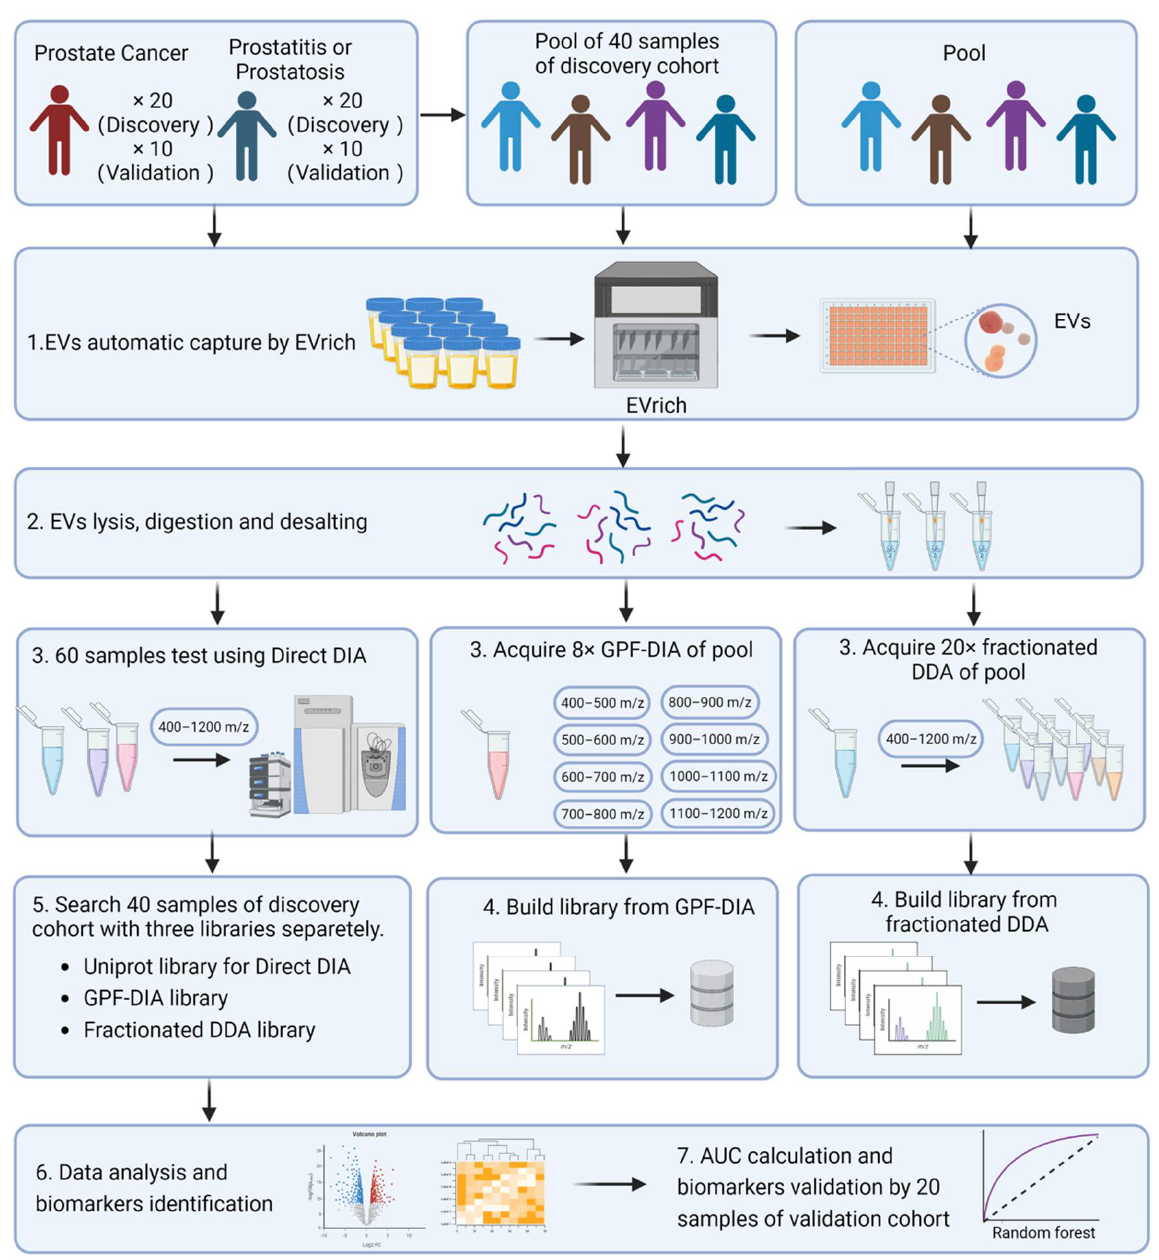
Figure 1. Experimental Design and Workflow of the Study. (Created by BioRender.com) EVs were separated in urine samples collected from all participants. We then used the EVTRAP method to capture and isolate the EVs. For the establishment of the library for MS searching, in this step, the samples from all 40 participants of the discovery cohort were pooled as the main library for GPF-DIA-base search, while other independent 40 biological samples were pooled and conducted as a secondary library for fractionated DDA-base DIA search. Meanwhile, the particle number and size of EVs were examined using Nanoparticle tracking analysis (NTA). In addition, the size and structure of extracted EV were examined by morphology using Transmission electron microscopy (TEM). Subsequently, the isolated EVs were lysed, digested, and desalted into peptides, then three strategies were performed for MS measurement and searching separately. The individual EV proteins were analyzed for discrimination between prostate cancer cases and non-prostate cancer controls, with the annotation on potential mechanistic pathways. Lastly, a random forest model for accessing the performance of classifying prostate outcomes was